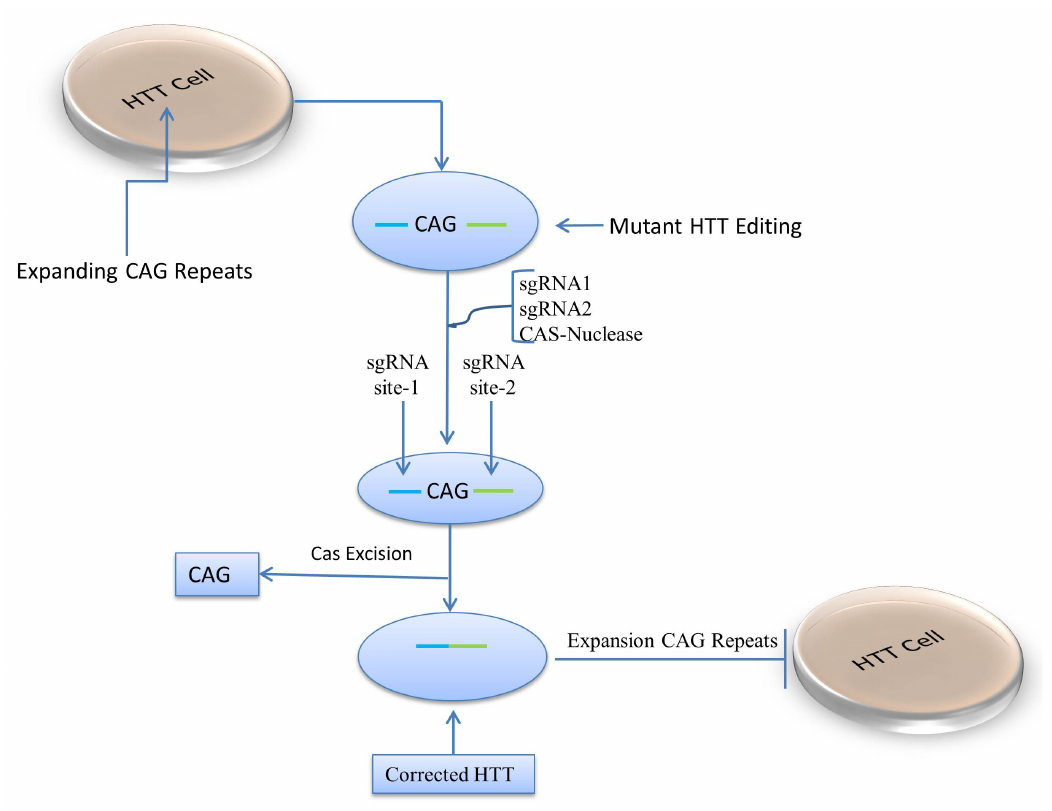
Figure 3. The CRISPR–Cas9 system used to correct extension repeats in the huntingtin gene ( HTT ) by using single-guide RNA (sgRNA) on both sides of the repeats and Cas9 nuclease, creating nicks and removing the CAG repeats, blocking further